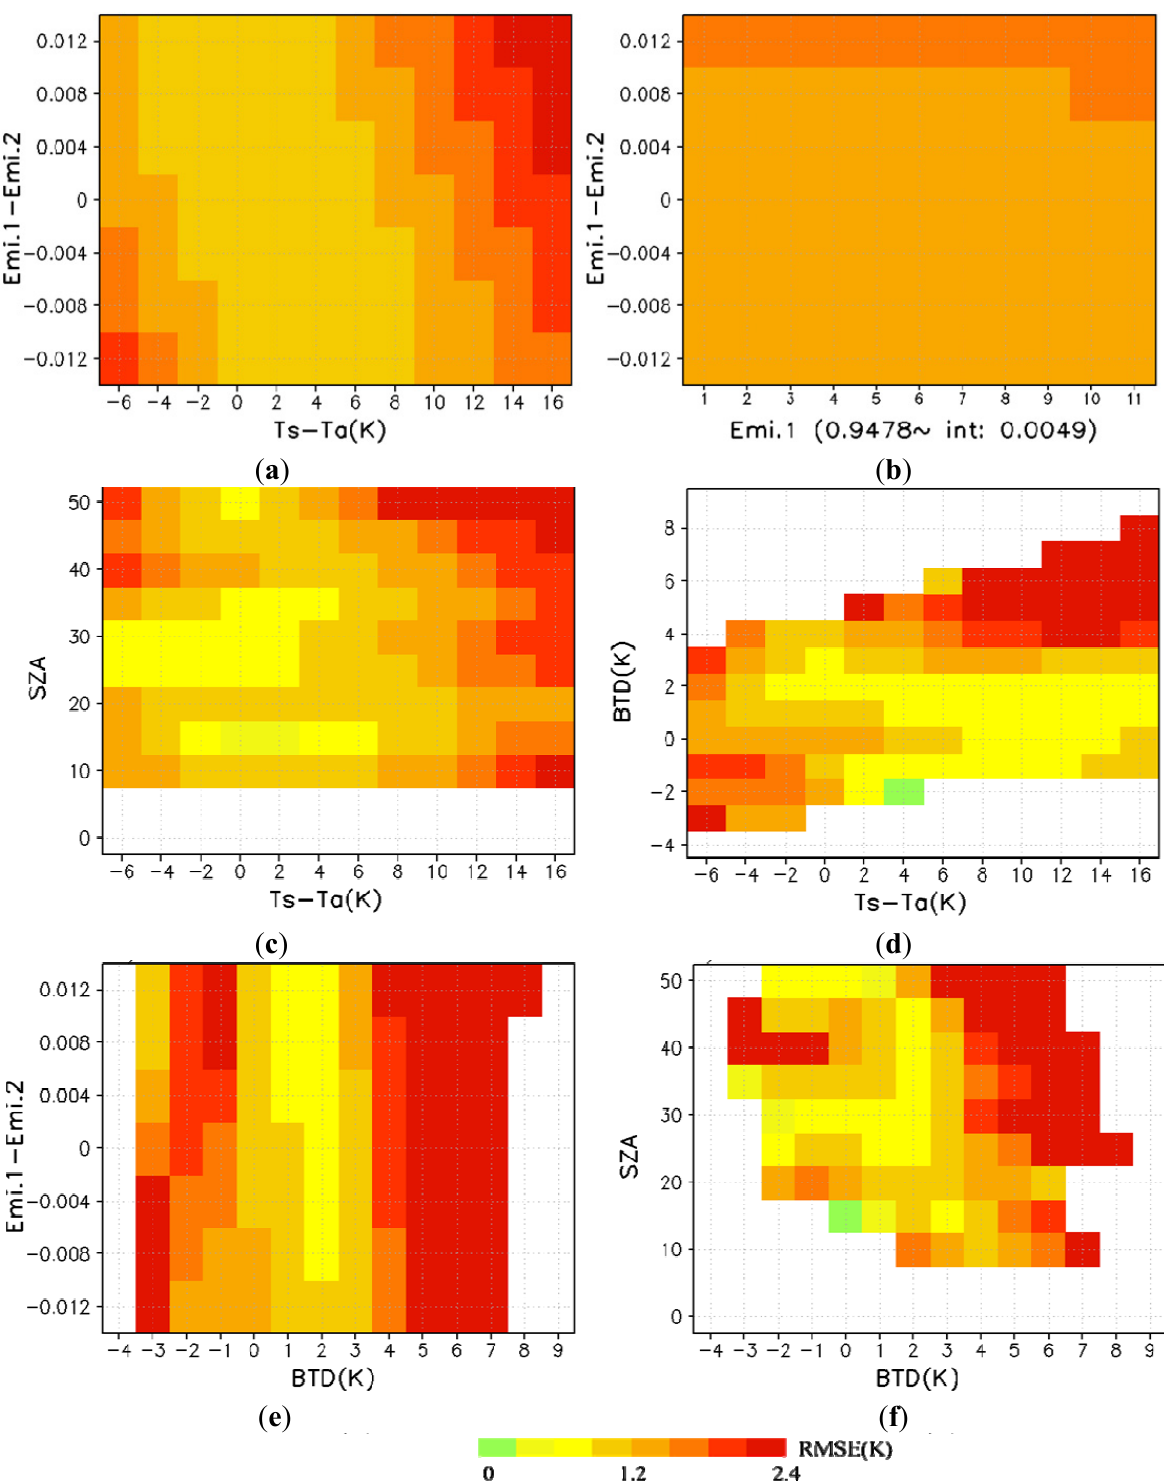
Figure 5. Distribution of RMSE for COMS Split-Window LST algorithm according to different impacting factors: ( a ) surface lapse rate and emissivity difference; ( b ) emissivity of infrared-1 and emissivity difference; ( c ) surface lapse rate and satellite zenith angle; ( d ) surface lapse rate and brightness temperature difference; ( e ) brightness temperature difference and emissivity difference; ( f ) brightness temperature difference and satellite zenith